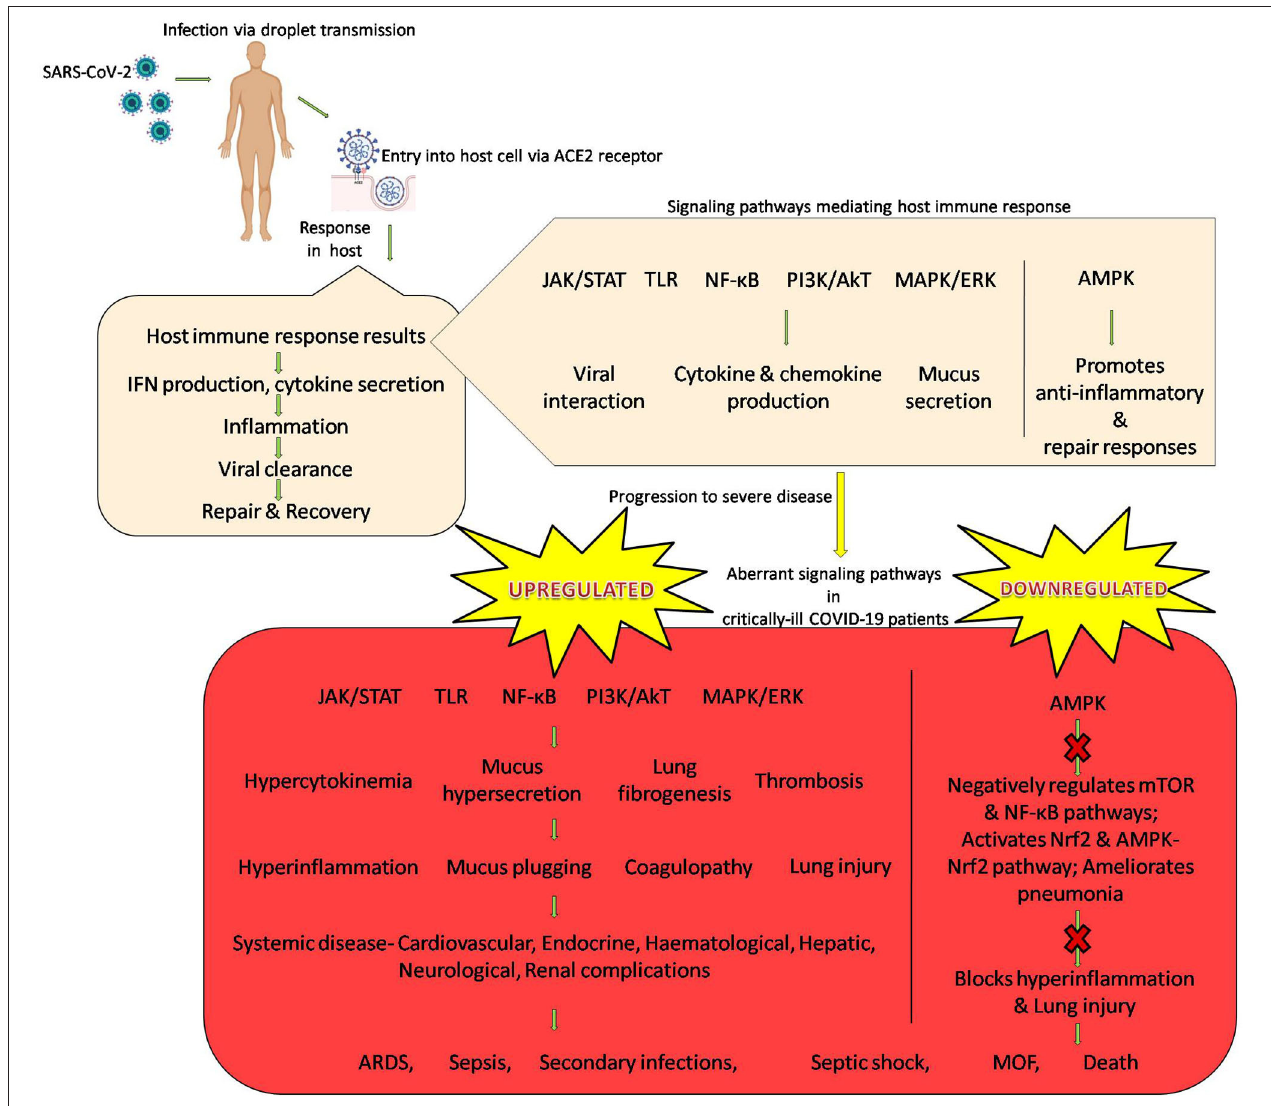
FIGURE 1 | SARS-CoV-2 infection and host immune response with emphasis on signaling